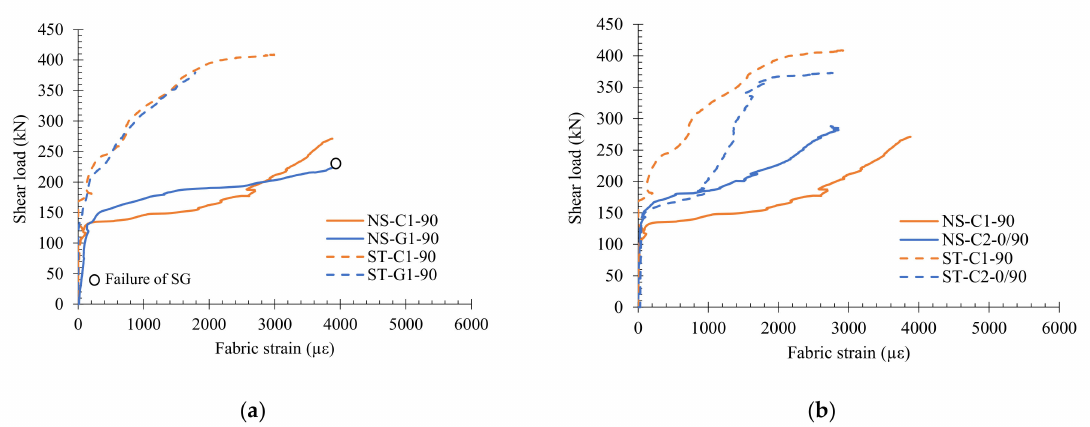
Figure 12. Typical fabric strain response: ( a ) Specimens with different matrices; ( b ) Specimens with different amounts of